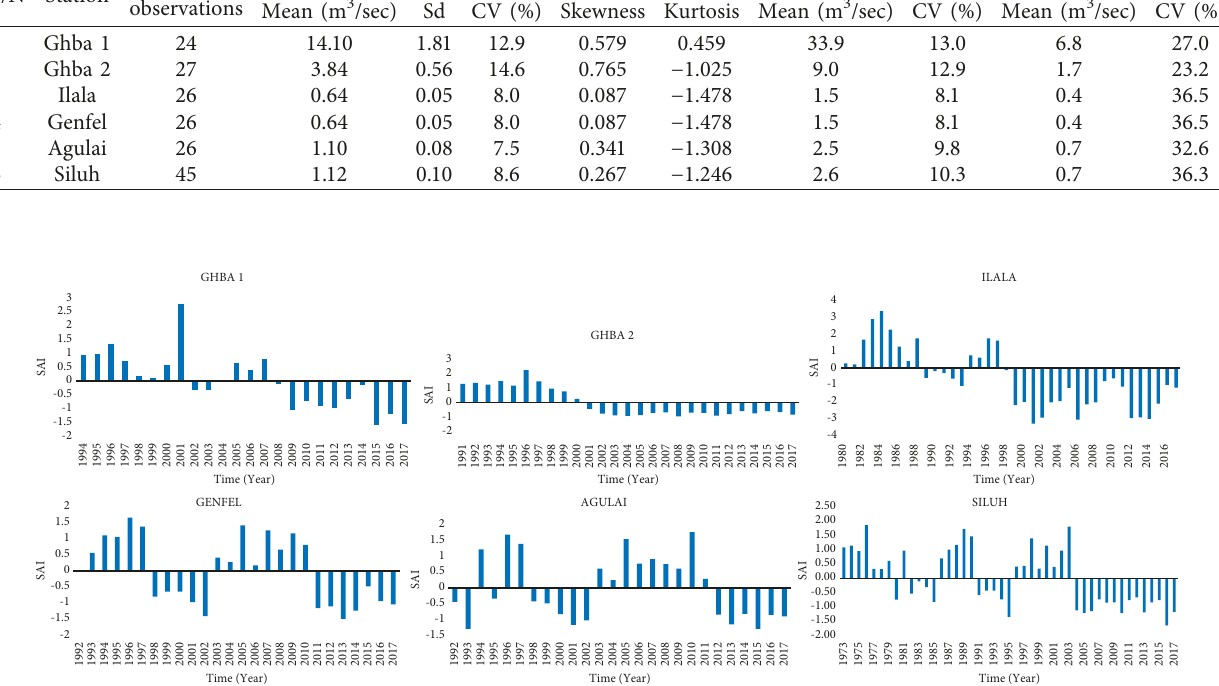
Figure 10: The annual standardized anomaly index (SAI) of streamflow stations in the